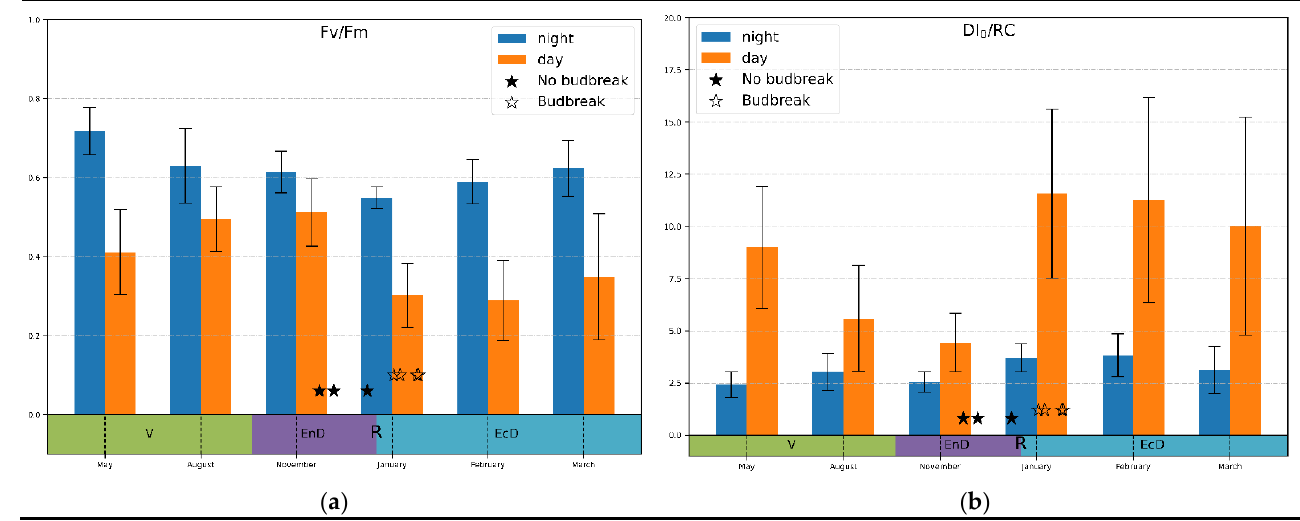
Figure 3. Monthly average values of ( a ) photosystem II quantum yield; ( b ) thermal dissipation per reaction center calculated at midnight and midday values (indicated on the graphs) during active vegetation (May), onset (August – November), maintenance (January) and release (February – March) of endo-dormancy. The annotations at the bottom denote approximate duration of dormancy and vegetation phases (V, vegetation period; EnD, endodormancy; EcD, ecodormancy; R, endodor- mancy release).